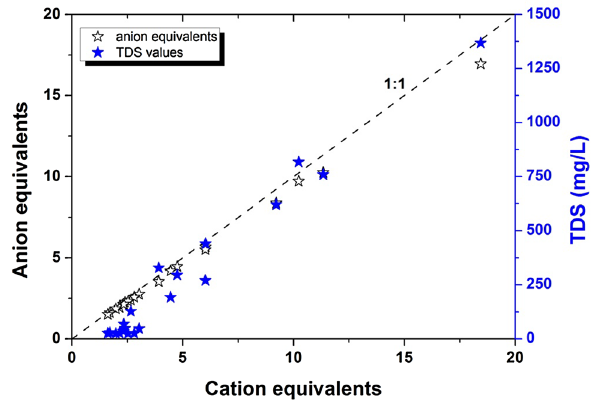
Fig. 4 Scatter plot of cation equivalents versus corresponding anion equivalents and TDS values of the water samples. The dashed line represents equimolar concentration